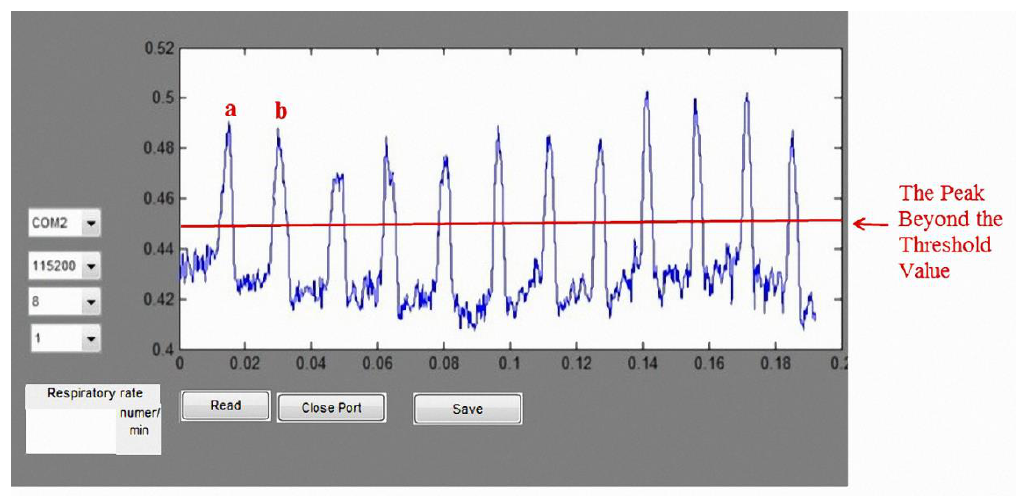
Figure 22. Wireless auscultation system user interface.